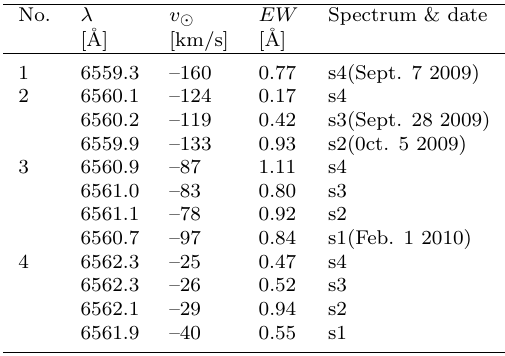
Fig. 2. Changes in the H (cid:11) line observed on 2010-02-01 { full line, on 2009-10-05 { dotted line, on 2009-09-28 { dashed line and on 2009-09-07 { dash-dotted line. The positions of components derived by Gaussian decomposition are indicated with vertical ticks and listed in Table 3. The position of the emission peak corresponds to the radial velocity of about {30 km s − 1 . Table 3. Results of the Gaussian decomposition of the H (cid:11) line in the spectra of 89 Her. The numbers correspond to the components in Figure 2 counting from blue to red. The velocities of the components are